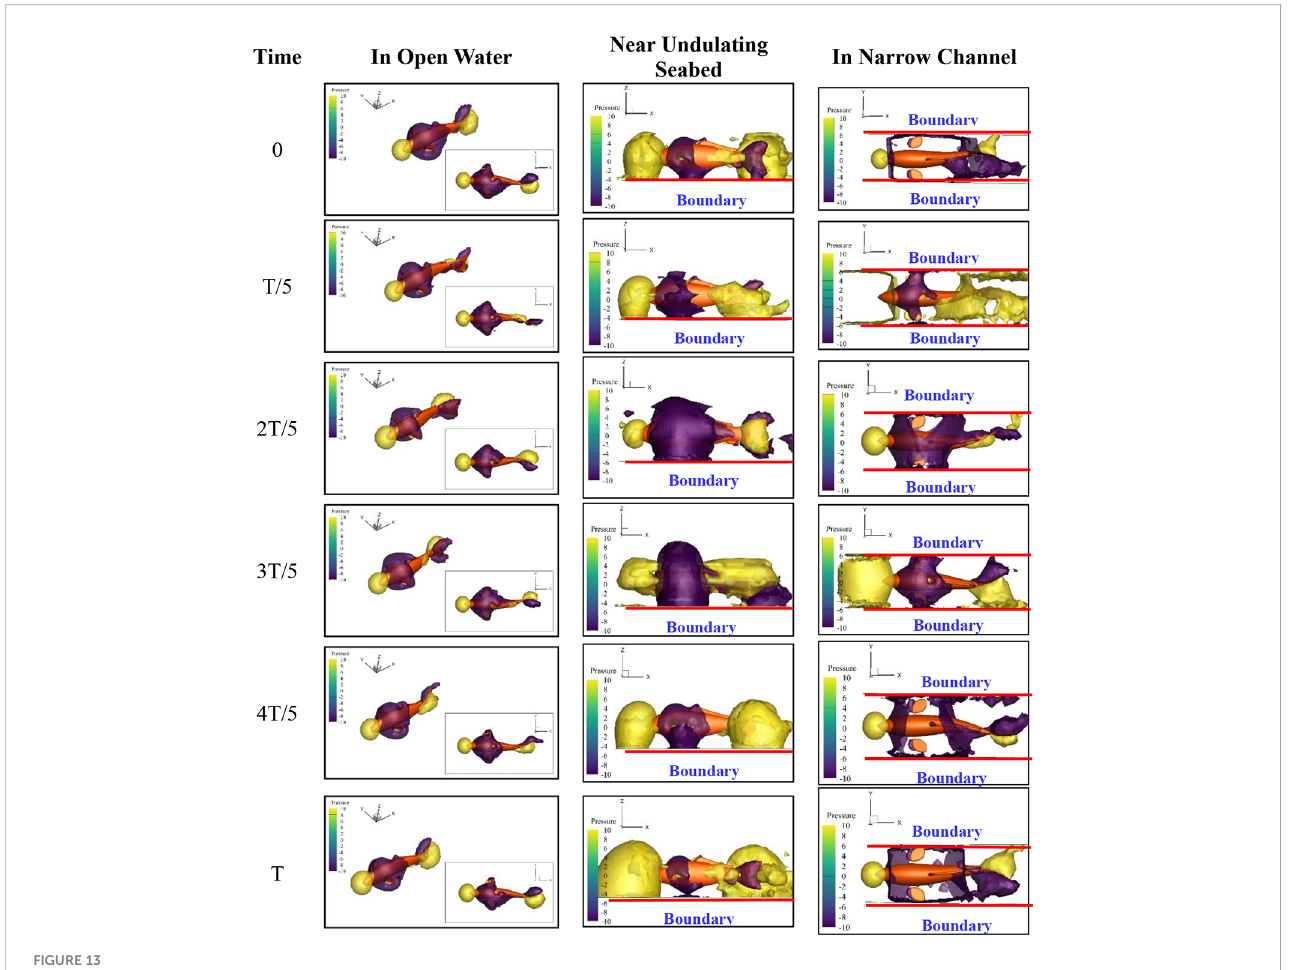
FIGURE 13 Pressure fi eld of the research